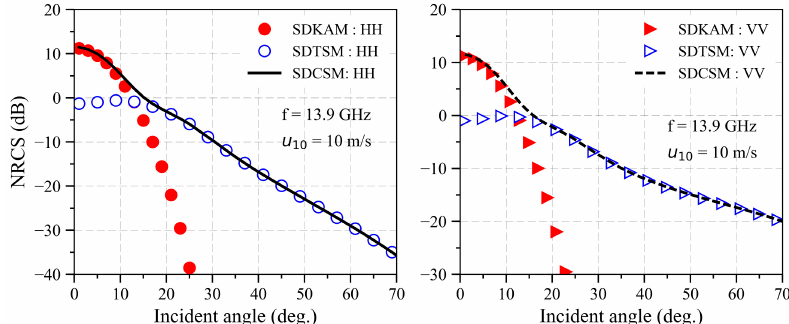
Figure 3. Normalized radar cross section (NRCS) of EM backscattering echoes from an electrically large sea surface versus the incident angles based on the Slope-Deterministic Kirchhoff Approximation Model (SDKAM), Slope-Deterministic Two-Scale Model (SDTSM), and slope-deterministic composite scattering model (SDCSM) when cutoff number is equal to k/3.